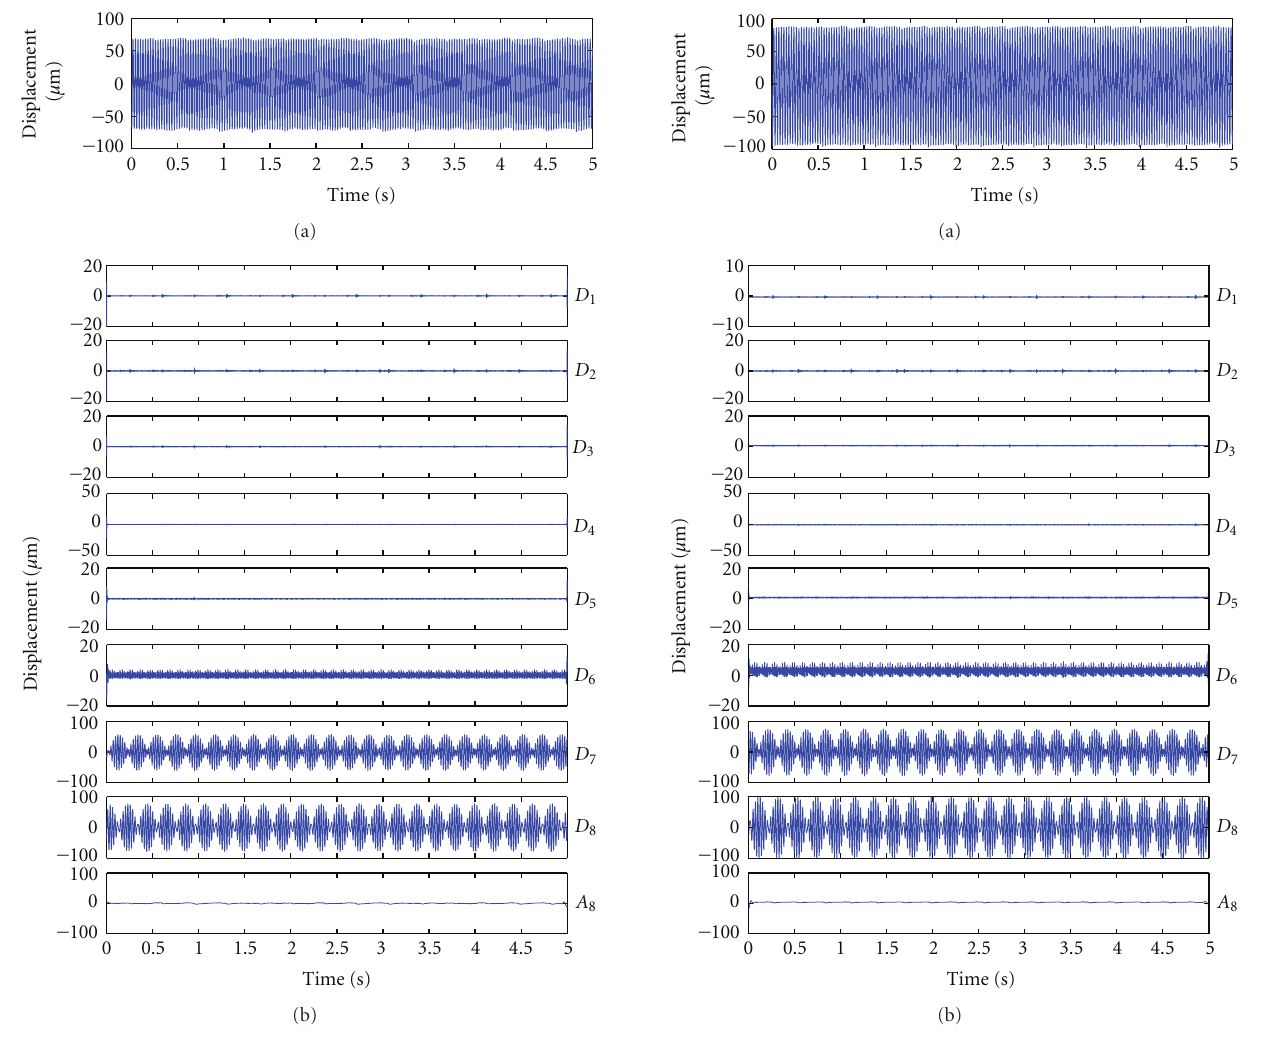
Figure 4: Time series plot (a) and multiresolution decomposition (b) of the vibration signal for healthy rotor with no excitation.